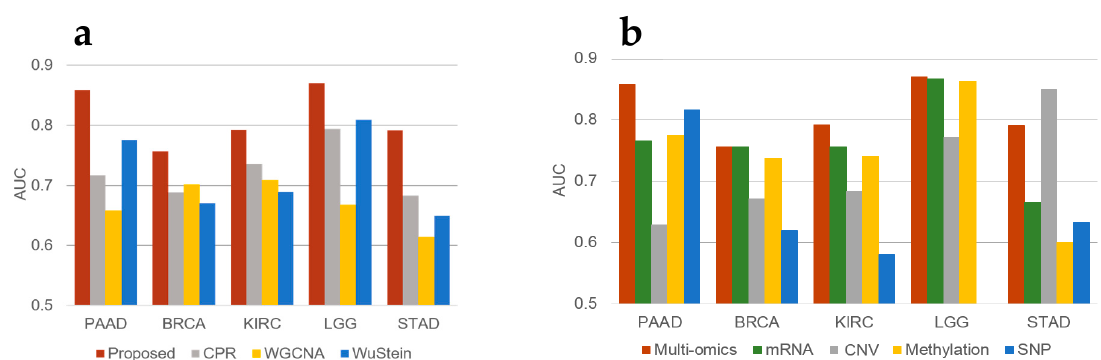
Figure 2. Prognostic accuracy in terms of area under the curve (AUC) for each ( a ) method and ( b ) omics dataset. CPR (Clustering and PageRank), WGCNA (weighted gene co-expression network analysis).